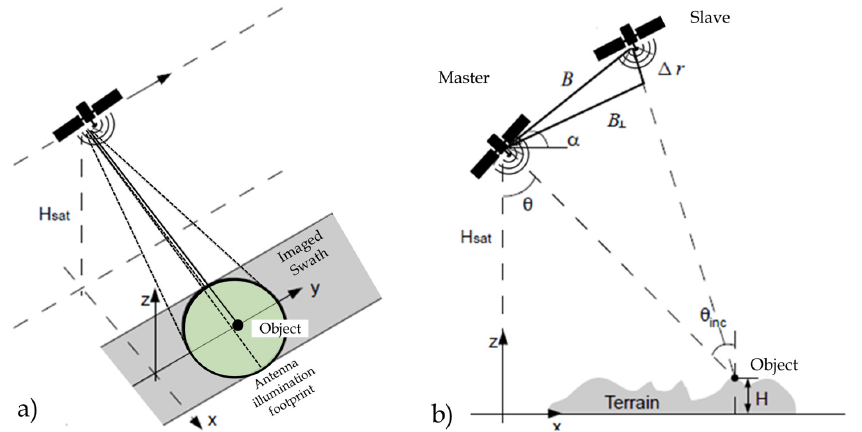
Figure 5. Side-looking satellite SAR data acquisition: ( a ) antenna illumination footprint; ( b ) sequence of acquisitions over the same area (master and slave